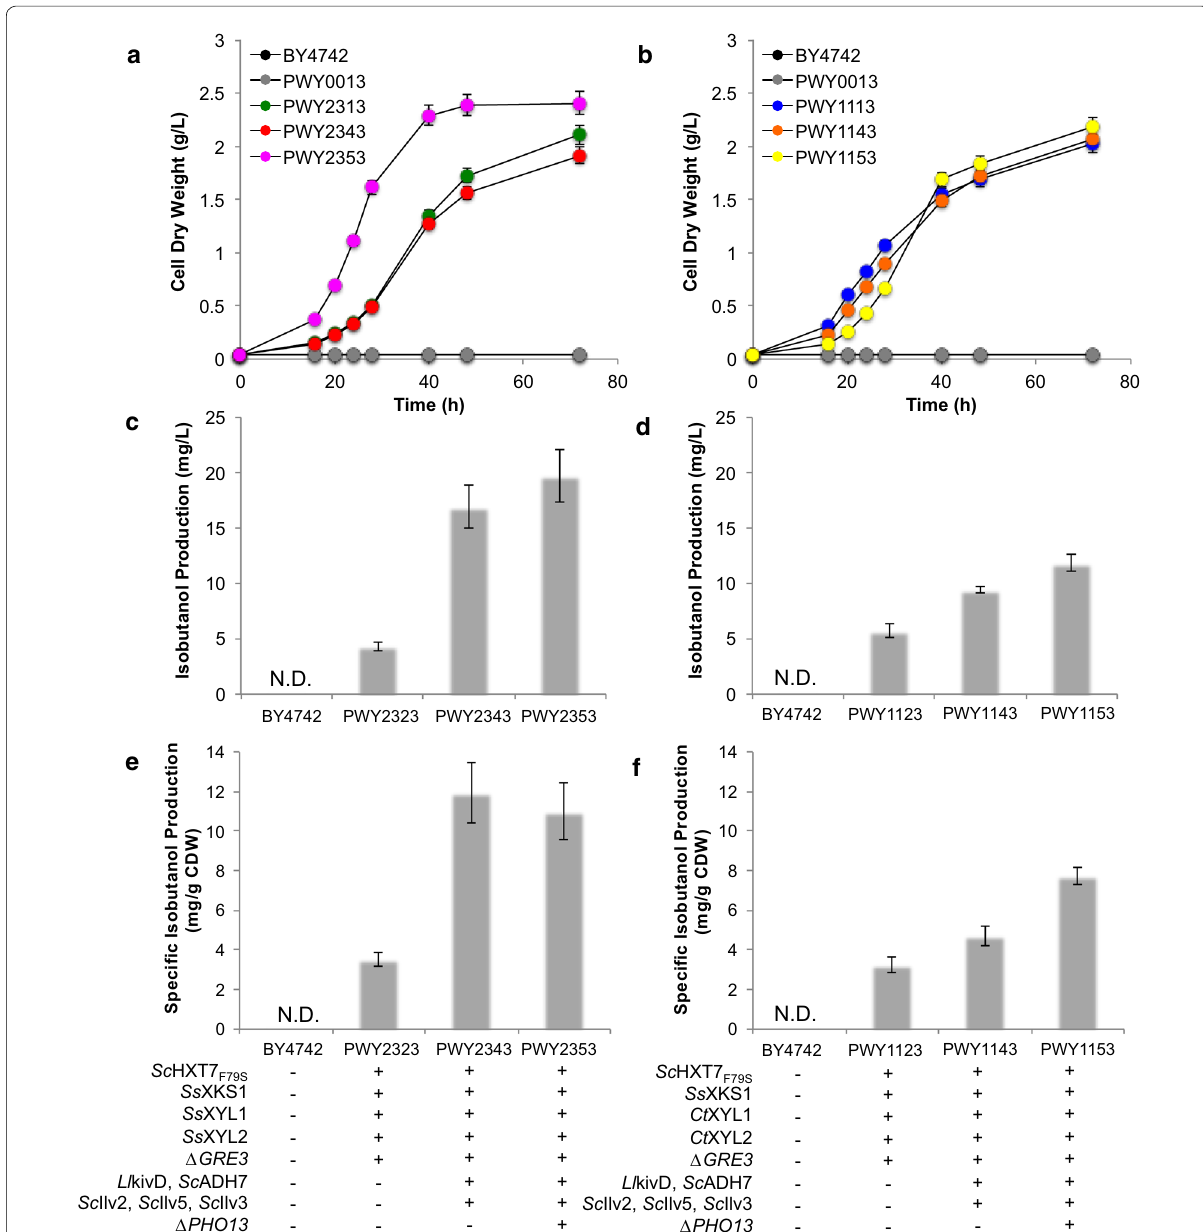
Fig. 3 Growth profile and isobutanol production of engineered strains in selective medium containing 2% xylose. Growth profiles of engineered strains expressing XR–XDH from S. stipitis ( a ) and C. tropicalis ( b ). Total ( c ) and specific ( e ) isobutanol production after 2 days of engineered strains expressing XR–XDH from S. stipitis . Total ( d ) and specific ( f ) isobutanol production after 2 days of engineered strains expressing XR–XDH from C. tropicalis . Engineered strains were pre-cultured in 5-mL aliquots in SD selective medium overnight and used to inoculate 10 mL fresh SX (2% xylose) to achieve an initial optical density of 0.05 at 600 nm (OD 600 ). The cultures were grown at 30 °C and 250 rpm in an orbital shaking incubator. Samples were taken after 2 days and the supernatants were analyzed on HPLC to quantify the isobutanol content. Values are the mean of three biological replicates standard deviation (n 3). N.D. represents not detected due to strain’s inability to grow. Ll, Lactococcus lactis ; Sc , ± = Saccharomyces cerevisiae ; Ss , Scheffersomyces stipitis ; Ct , Candida